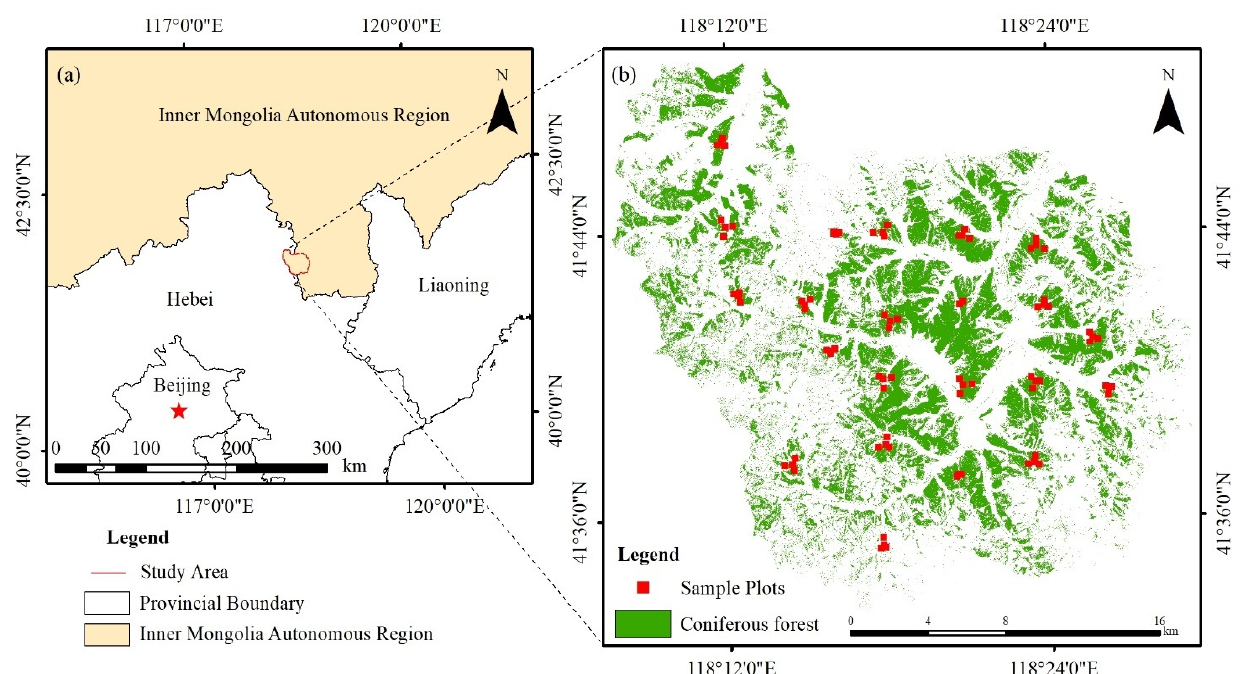
Figure 1. ( a ) Locations of the study area and ( b ) distribution of sample plots within the coniferous forest in the Wangyedian forest farm.